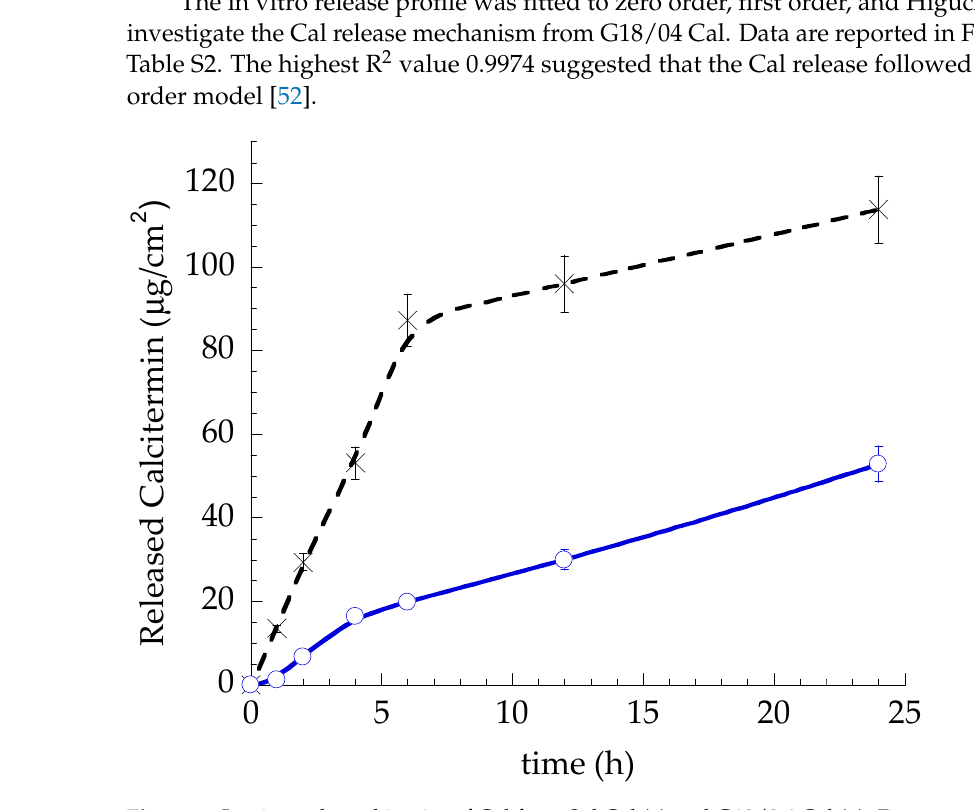
Table 4. Antifungal activity of Cal in aqueous buffer (AB).